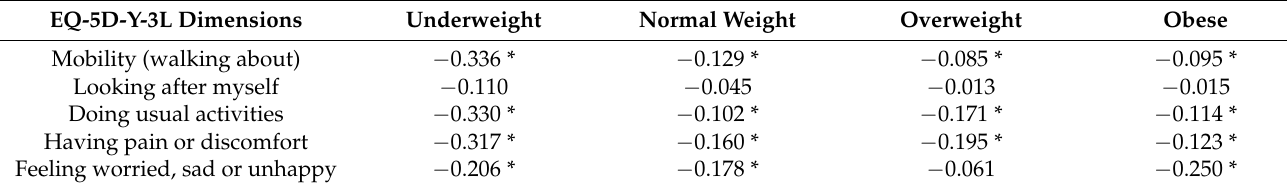
Table 3. Convergent validity: Spearman’s correlation